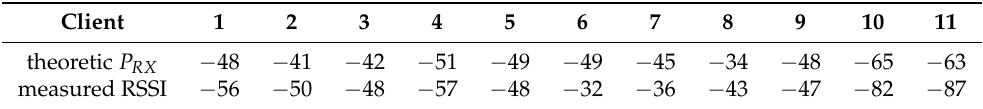
Table 3. Theoretic received power [dBm] and measured RSSI [dBm] for the clients (located at the positions indicated in Figure